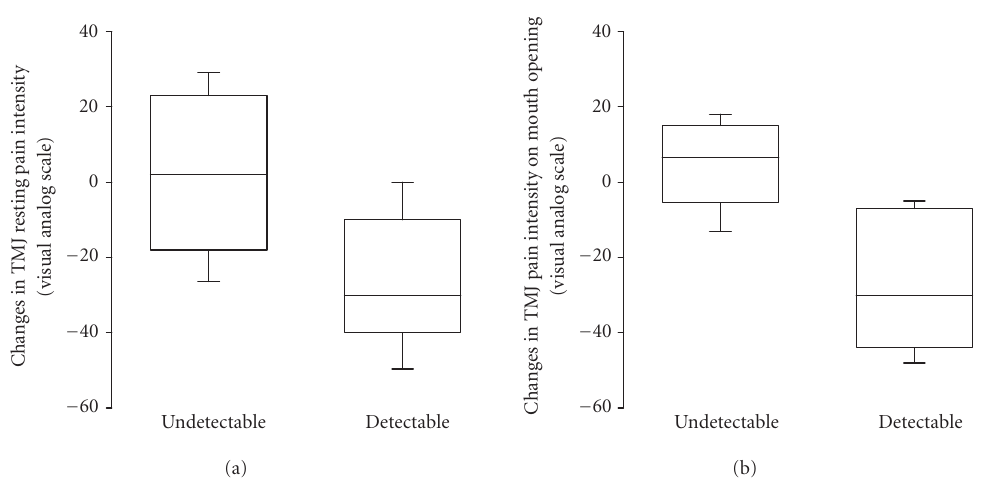
Figure 1. (a) Changes in temporomandibular joint (TMJ) resting pain intensity after intra-articular glucocorticoid treatment in 9 patients with undetectable ( < 0 . 5nmol/L) and 11 patients with detectable pretreatment levels of serotonin (5-HT) in the TMJ synovial fluid and chronic inflammatory joint disease. There was a negative correlation between 5-HT and change in resting pain after treatment ( r s = − 0 . 52, n = 20, P = . 018). (b) Changes in TMJ pain intensity on mouth opening in 8 patients with undetectable ( < 0 . 5 nmol/L) and 5 patients with detectable pretreatment levels of 5-HT in TMJ synovial fluid and chronic inflammatory joint disease. There was a negative correlation between 5-HT and change in pain intensity on mouth opening after treatment ( r s = − 0 . 57, n = 13, P = . 041).